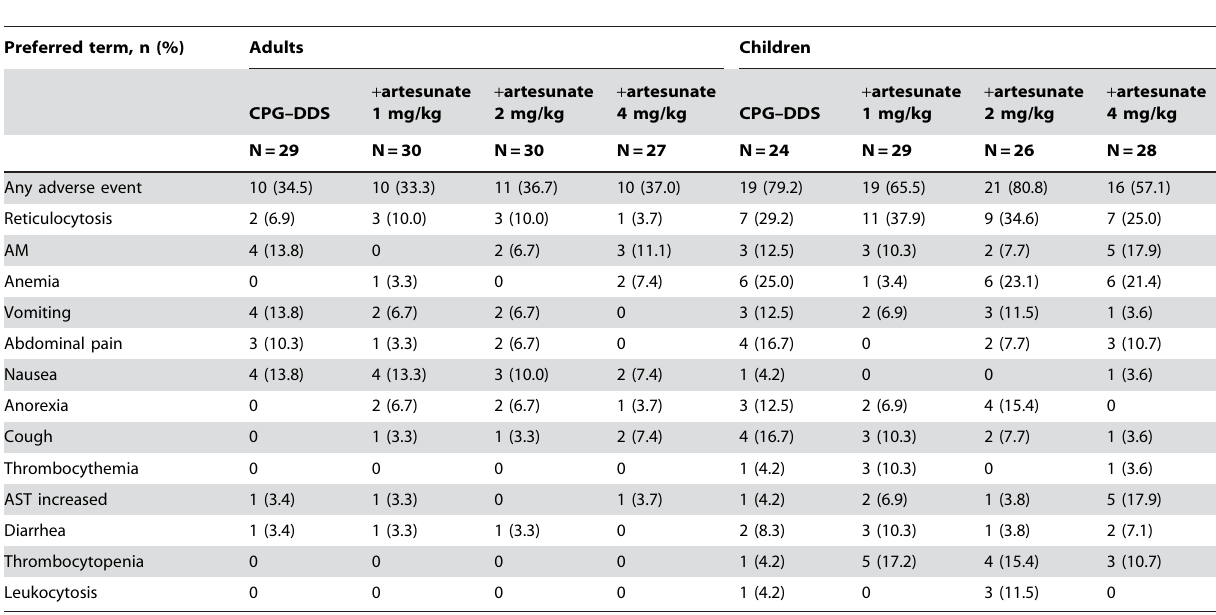
Table 5. Treatment emergent investigational drug-related adverse events reported during the study and the most common adverse events reported in $ 10% of patients in any treatment group for the intent to treat (safety) population.